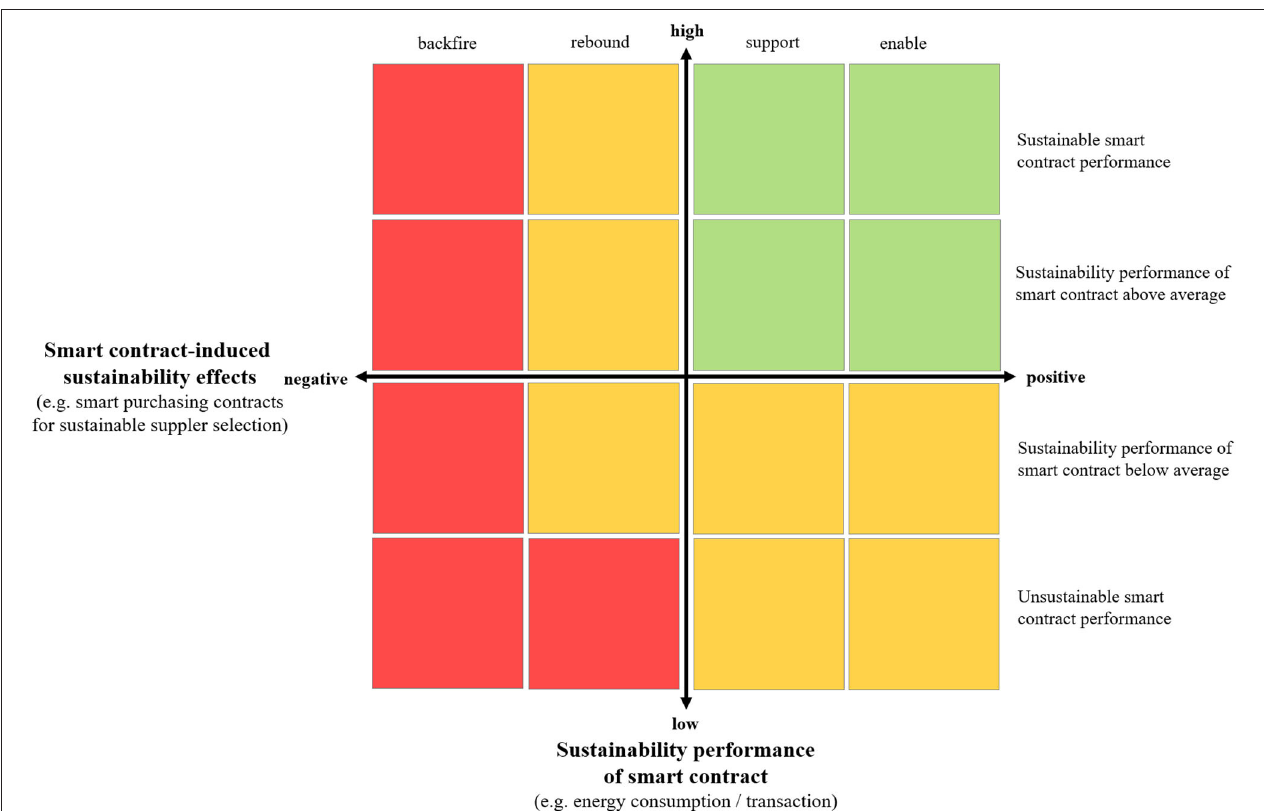
FIGURE 2 | Semi-structured assessment framework for sustainability effects of smart